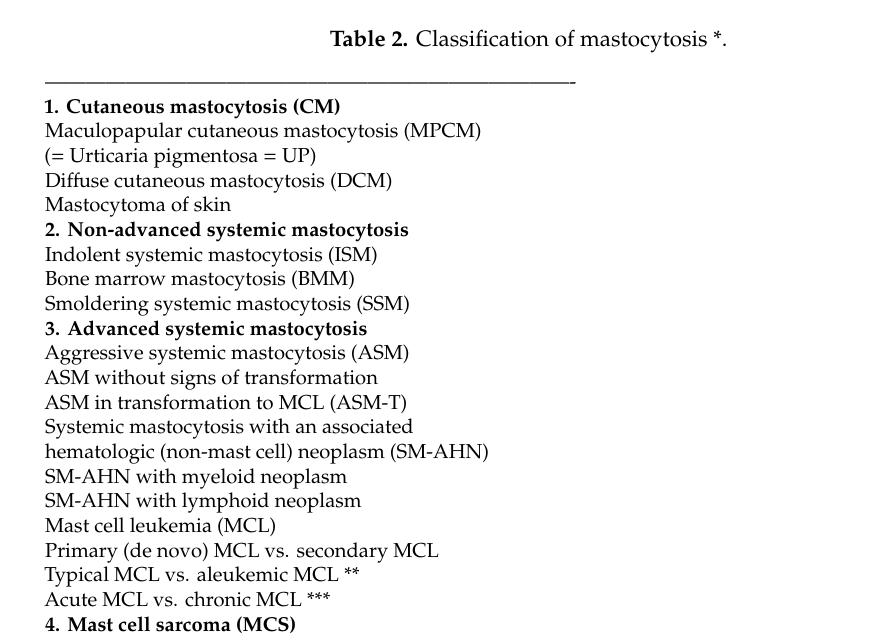
Table 2. Classification of mastocytosis